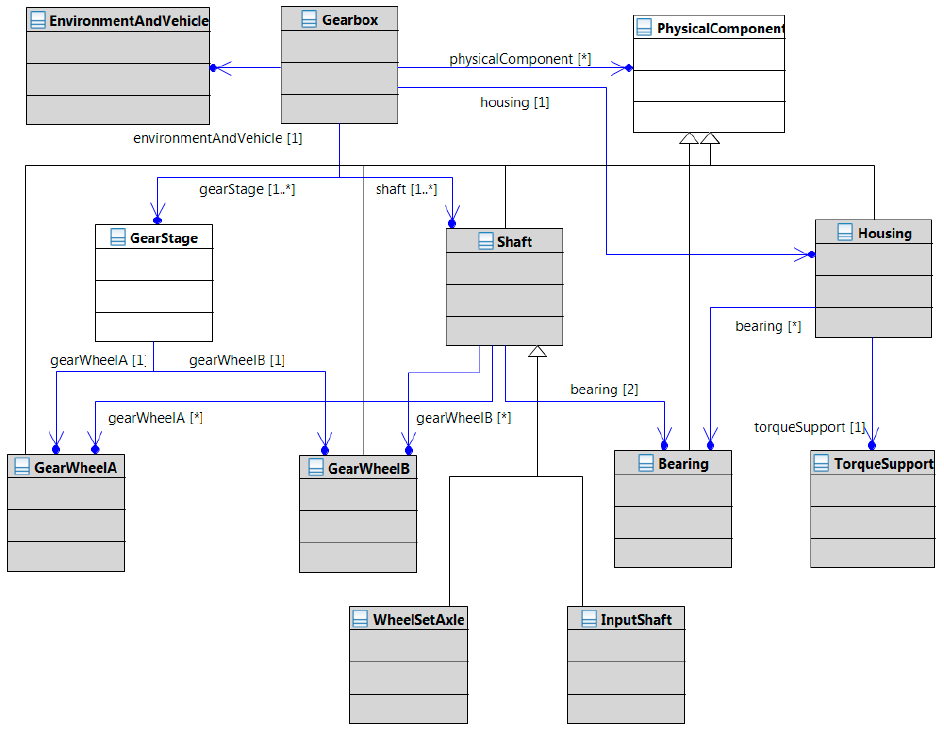
Figure 11. Simplified class diagram of a model for generating gear systems design variants.